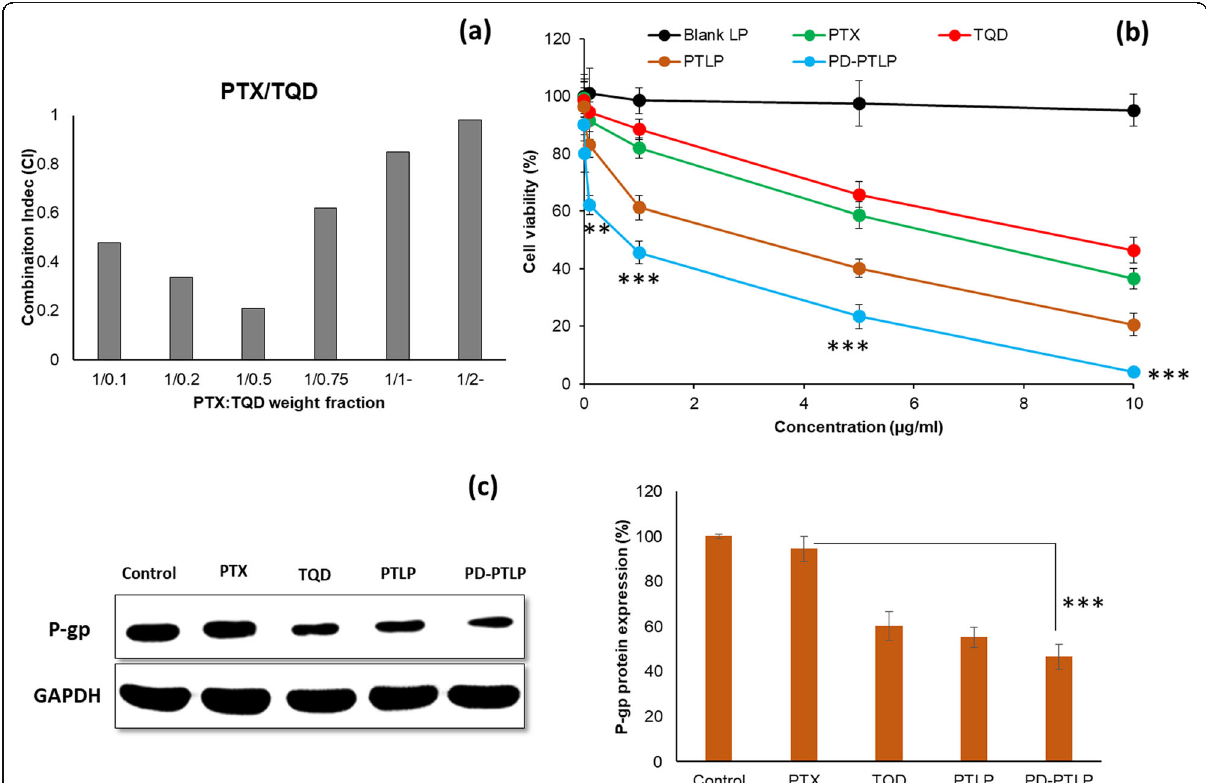
Fig. 4 a Combination index (CI) of different weight fractions of PTX and TQD in SGC7901/ADR cells. The combination index was evaluated by Calcusyn TM software. b In vitro cell viabilities of SGC7901/ADR cells after treatment with various concentrations of free PTX, TQD, PTLP, and PD- PTLP for 24-h incubation period. c Western blot analysis of p-gp expression in SGC7901/ADR cells after treatment with respective formulations. ** p < 0.01 and *** p < 0.001 is the statistical difference between free PTX and PD-PTLP-treated